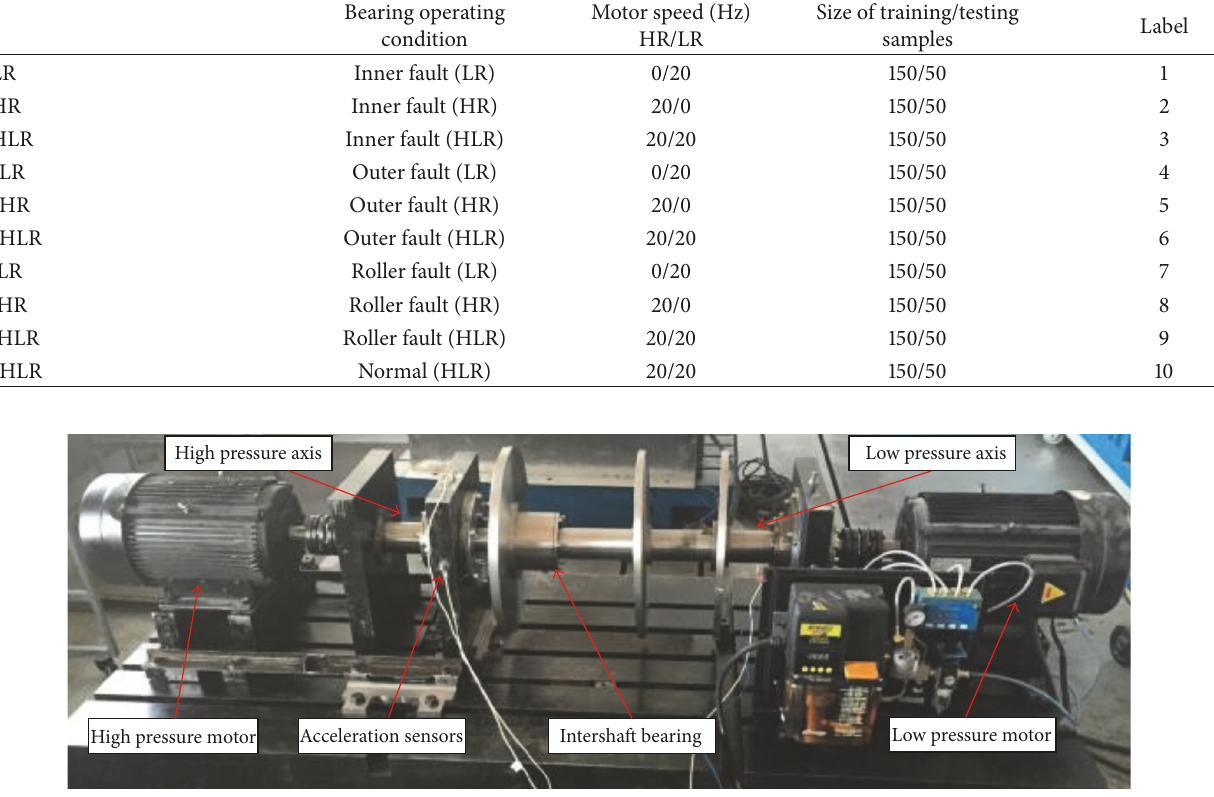
Figure 3: The test rig of aeroengine intershaft bearing.